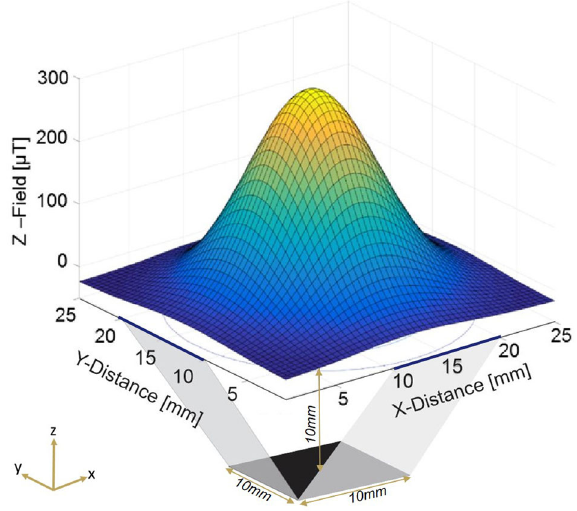
Fig. 7 Magnetic- fi eld distribution. a Composite magnet sample with a thickness of 170 µm. b 3D surface plot of the z component of the magnetic fi eld on the xy -plane at z = 10 mm above the